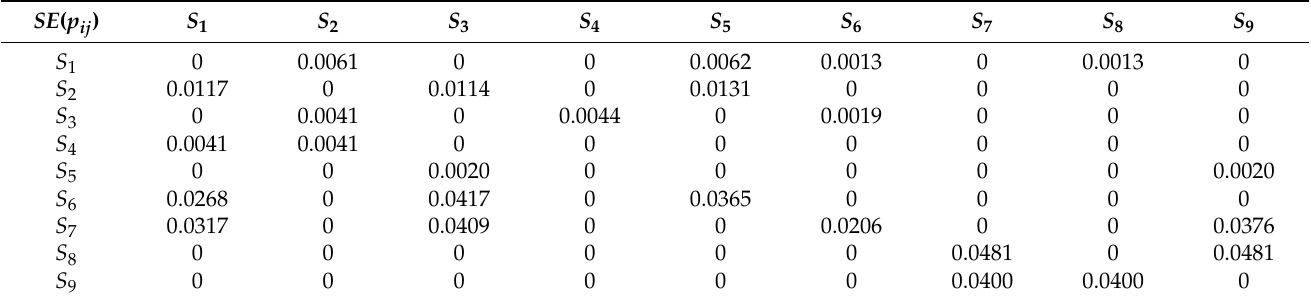
Table 5. Standard errors of probabilities